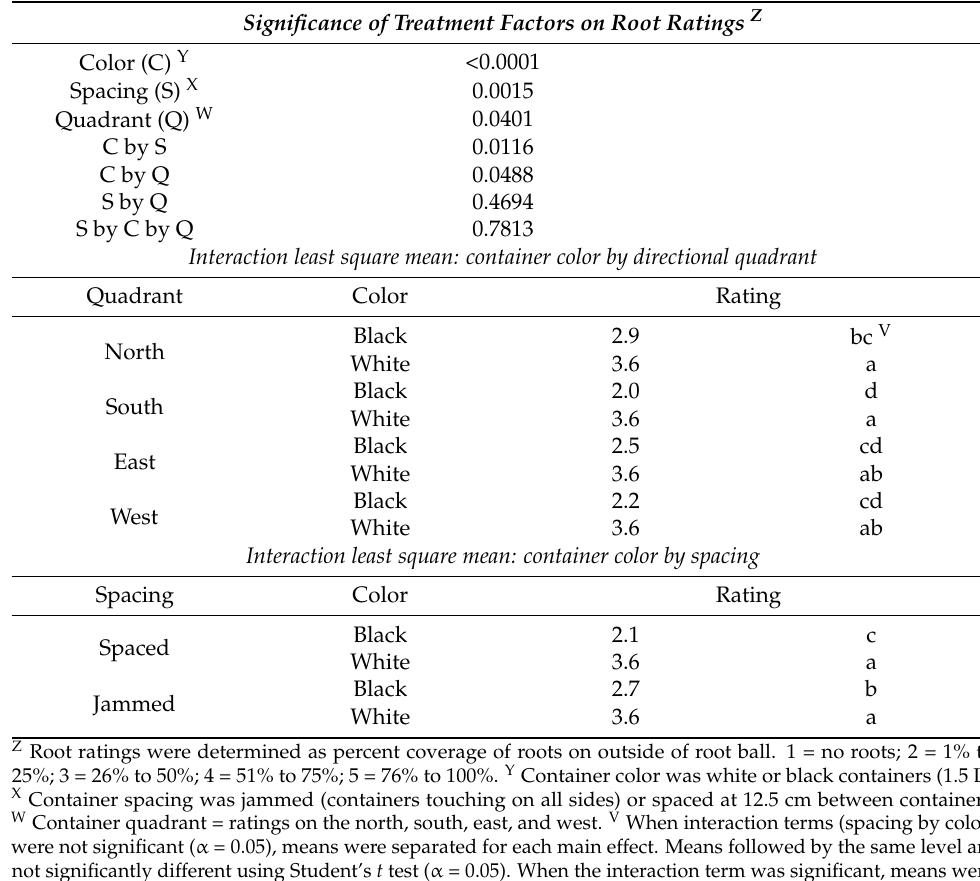
Table 2. Effects of container color, container spacing, and directional quadrant on root ratings of ‘Soft Touch’ Japanese holly grown in combinations of container color and spacing.